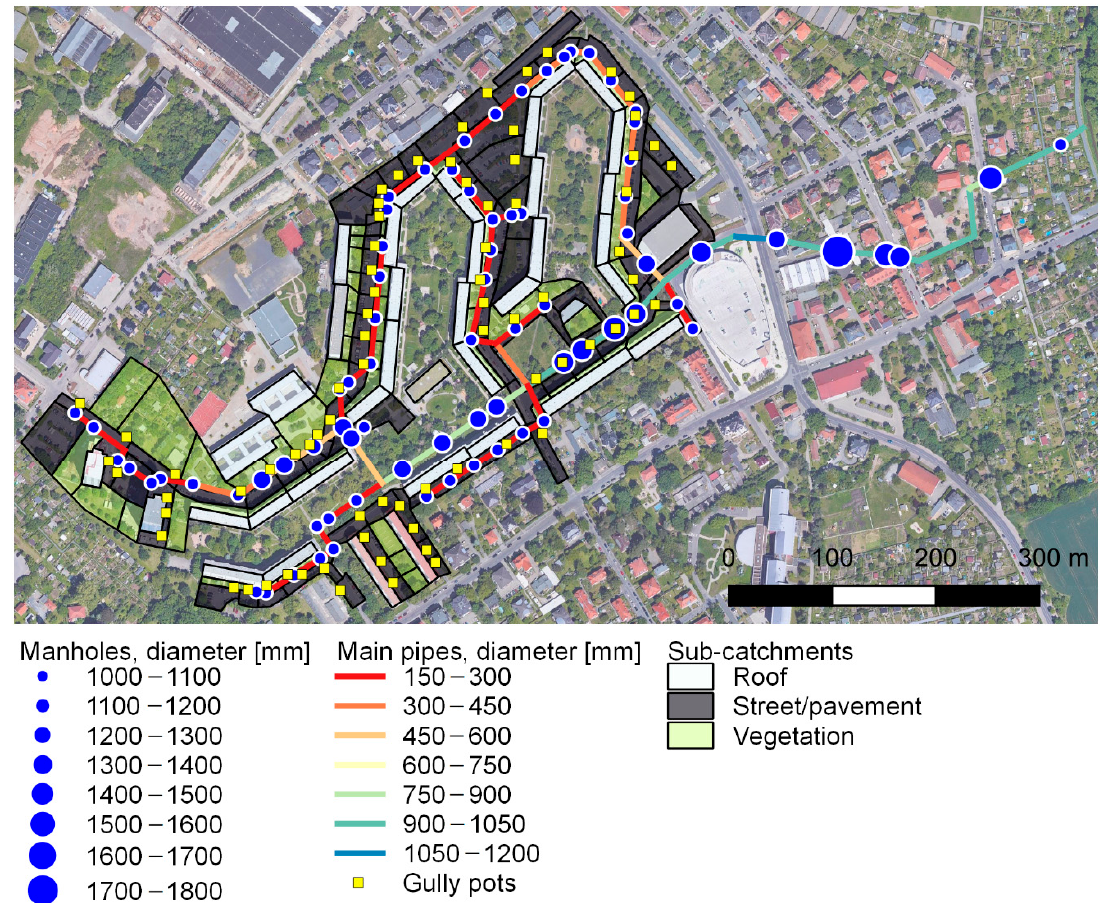
Figure 3. Study area with delineated sub-catchments and separated stormwater sewer system (SWSS) (Pseudo-Mercator projection). For rectangular pipe / manhole shapes, an equivalent circular diameter is calculated.